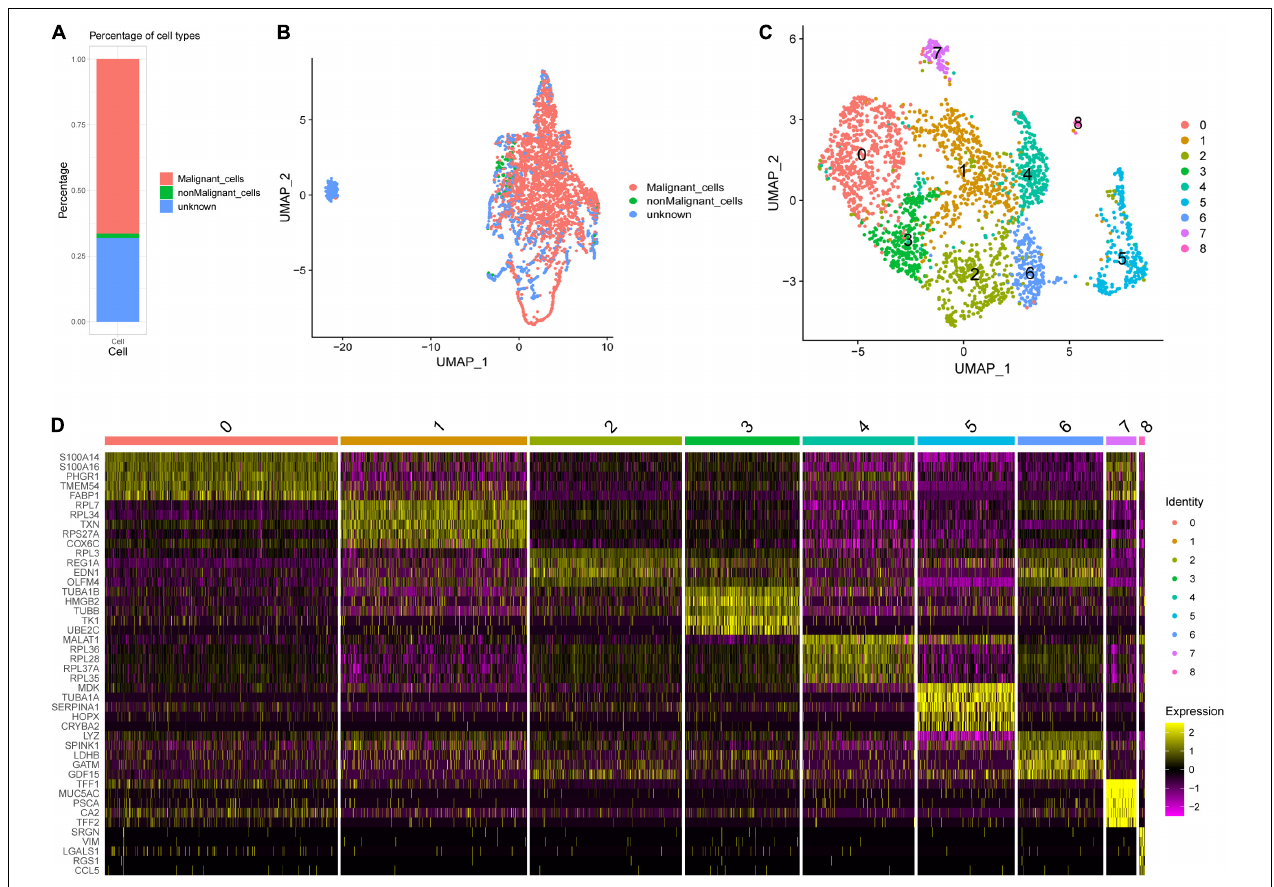
FIGURE 3 | Single-cell RNA sequencing (scRNA-seq) analysis in an early STAD. (A) Percentages of cell types identified by SCINA package. (B) Scatterplot for uniform manifold approximation and projection (UMAP) using the malignant and non-malignant marker genes. (C) The UMAP plot of malignant cells, showing cell clusters. (D) The relative expression heat map for malignant cell cluster markers. Only the top five are